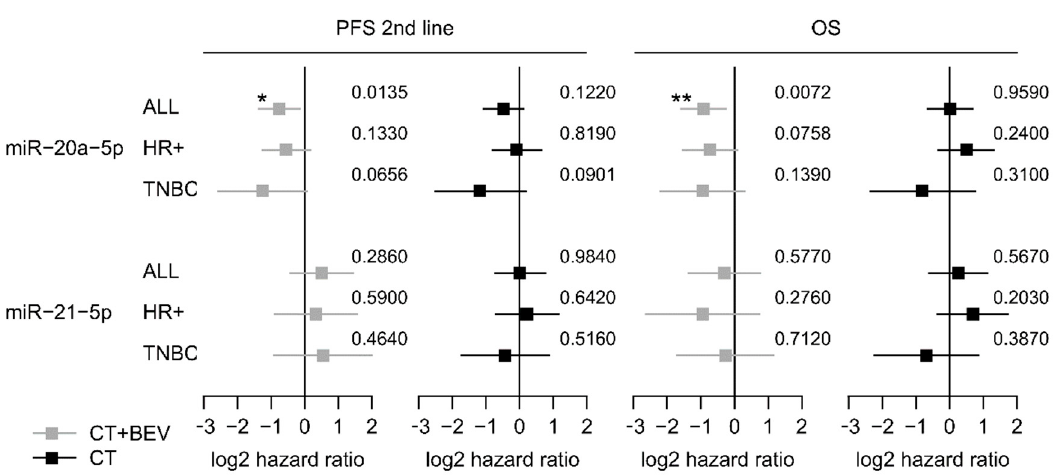
Figure 3. Forest plots for second-line PFS and OS based on the expression levels of miR-20a-5p and miR-21-5p in the TANIA trial. Log 2-hazard ratio (HR) and 95%-CI (forest plots) for second-line PFS and OS based on the dichtomized expression levels (low vs. high). of miR-20a-5p and miR-21-5p in the whole biomarker cohort of the TANIA trial as well as in the triple-negative and HR-positive subgroup. (*** p < 0.001, ** 0.001 ≤ p < 0.01, * 0.01 ≤ P < 0.05; exact p values on the right). Table 3. Multivariate analysis for second-line PFS and OS in the biomarker cohort of the TANIA trial. 2nd-Line PFS